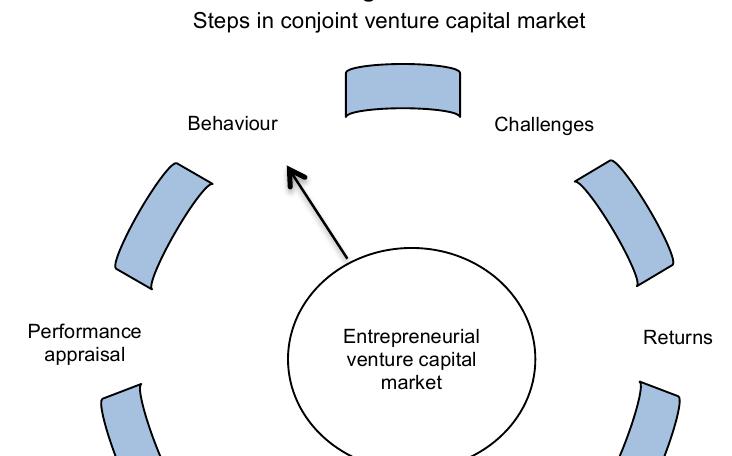
Entrepreneurial venture